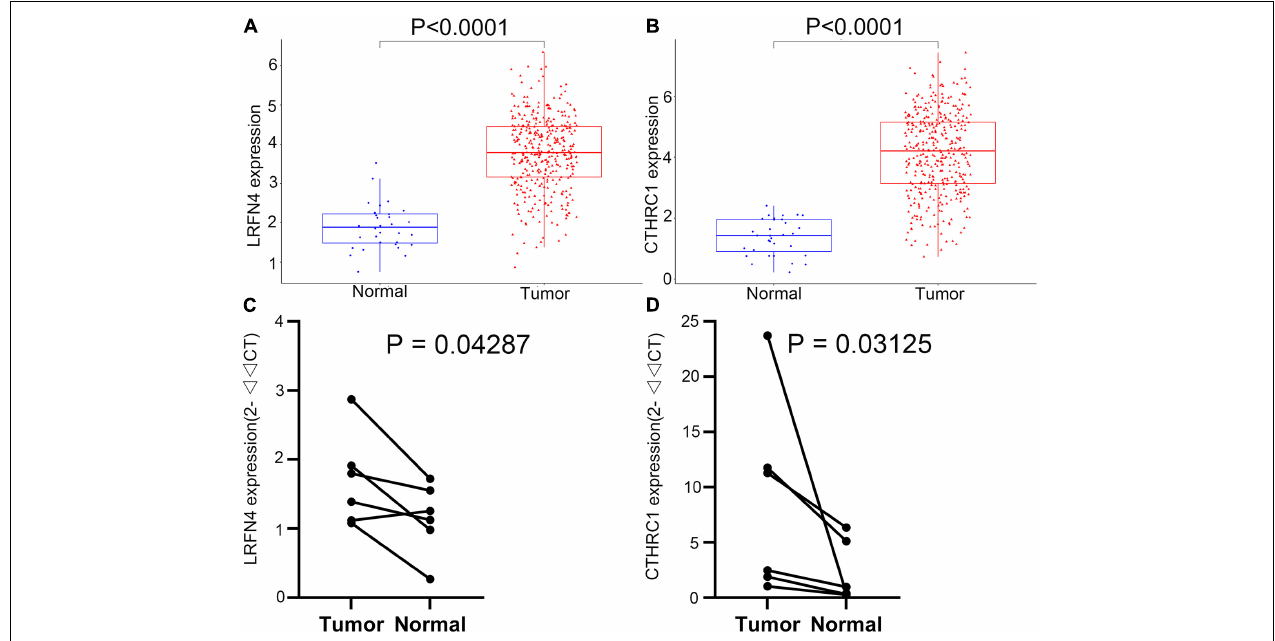
FIGURE 8 | Verification of the expression of LRFN4 and CTHRC1 . Expression of LRFN4 (A) and CTHRC1 (B) in the TCGA dataset. qRT-PCR validation of the expression of LRFN4 (C) and CTHRC1 (D)